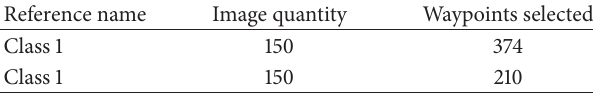
Table 1: Result of preparatory